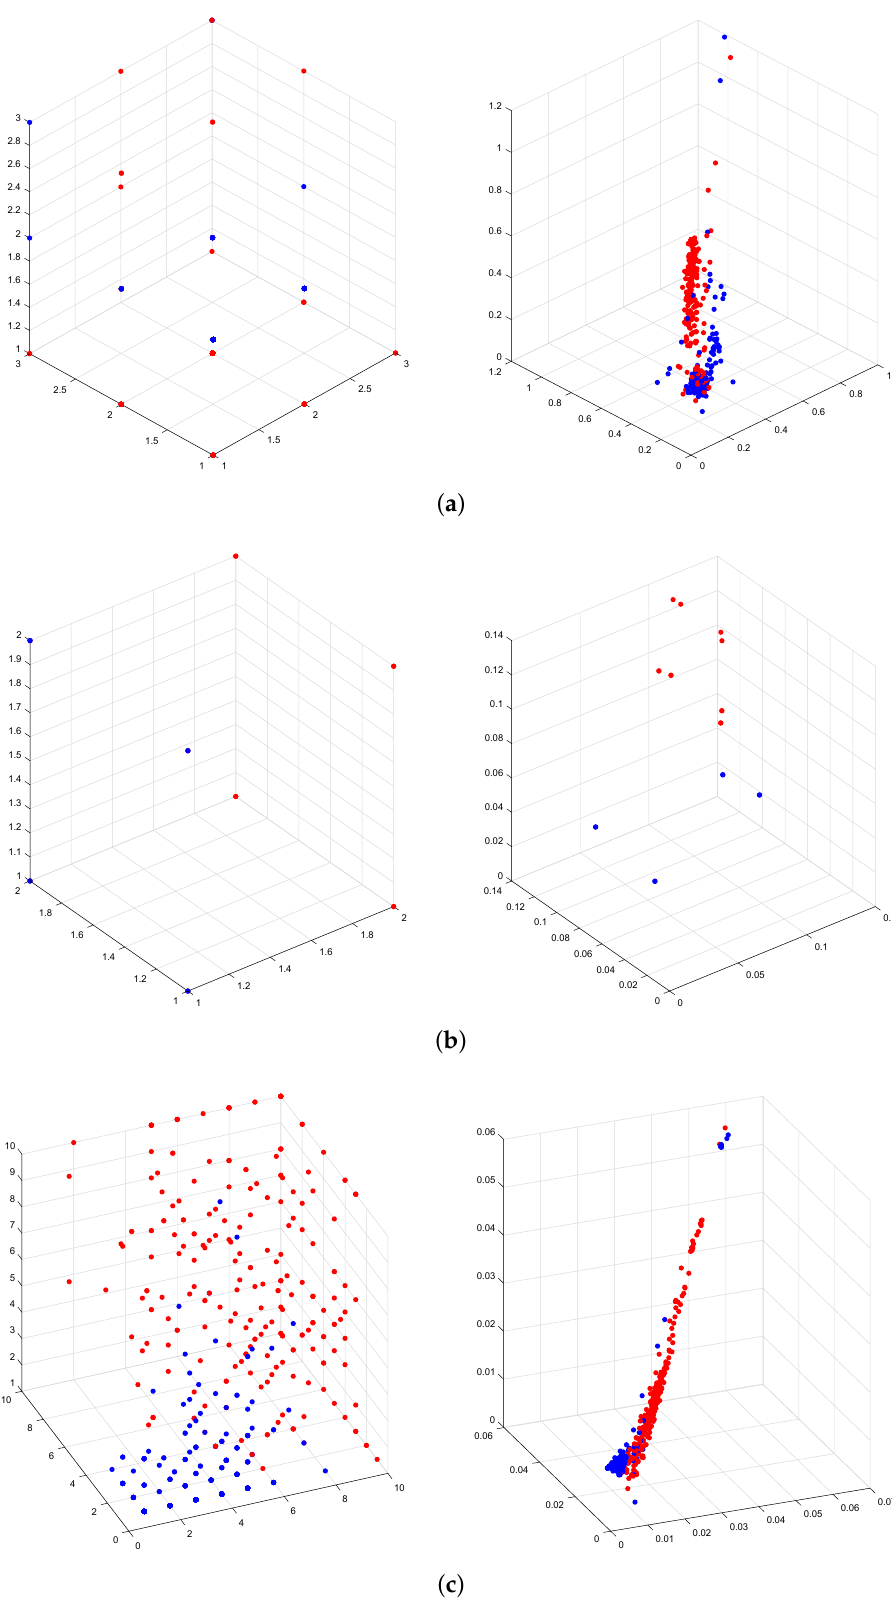
Figure 1. Initial categorical input space taking three attributes ( left ) and mapped features with Chi-tSNE ( right ) for: ( a ) Congressional Voting Records, ( b ) Balloons, and ( c ) Breast Cancer. Red and blue dots correspond to class 1 and 2, respectively. Each dimension of subfigures is a random